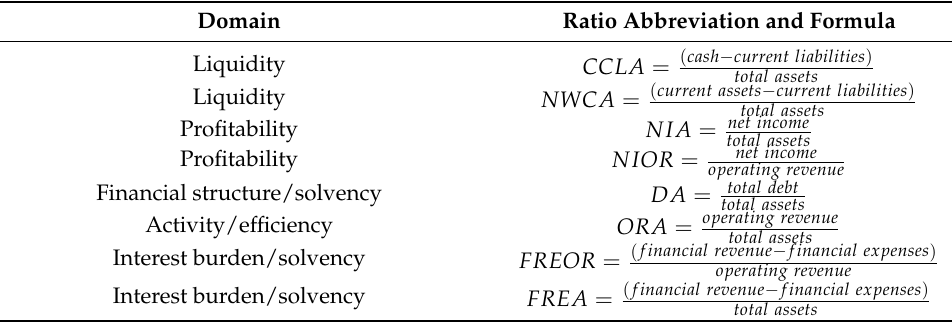
Table 2. Financial ratios’ domains, abbreviations and